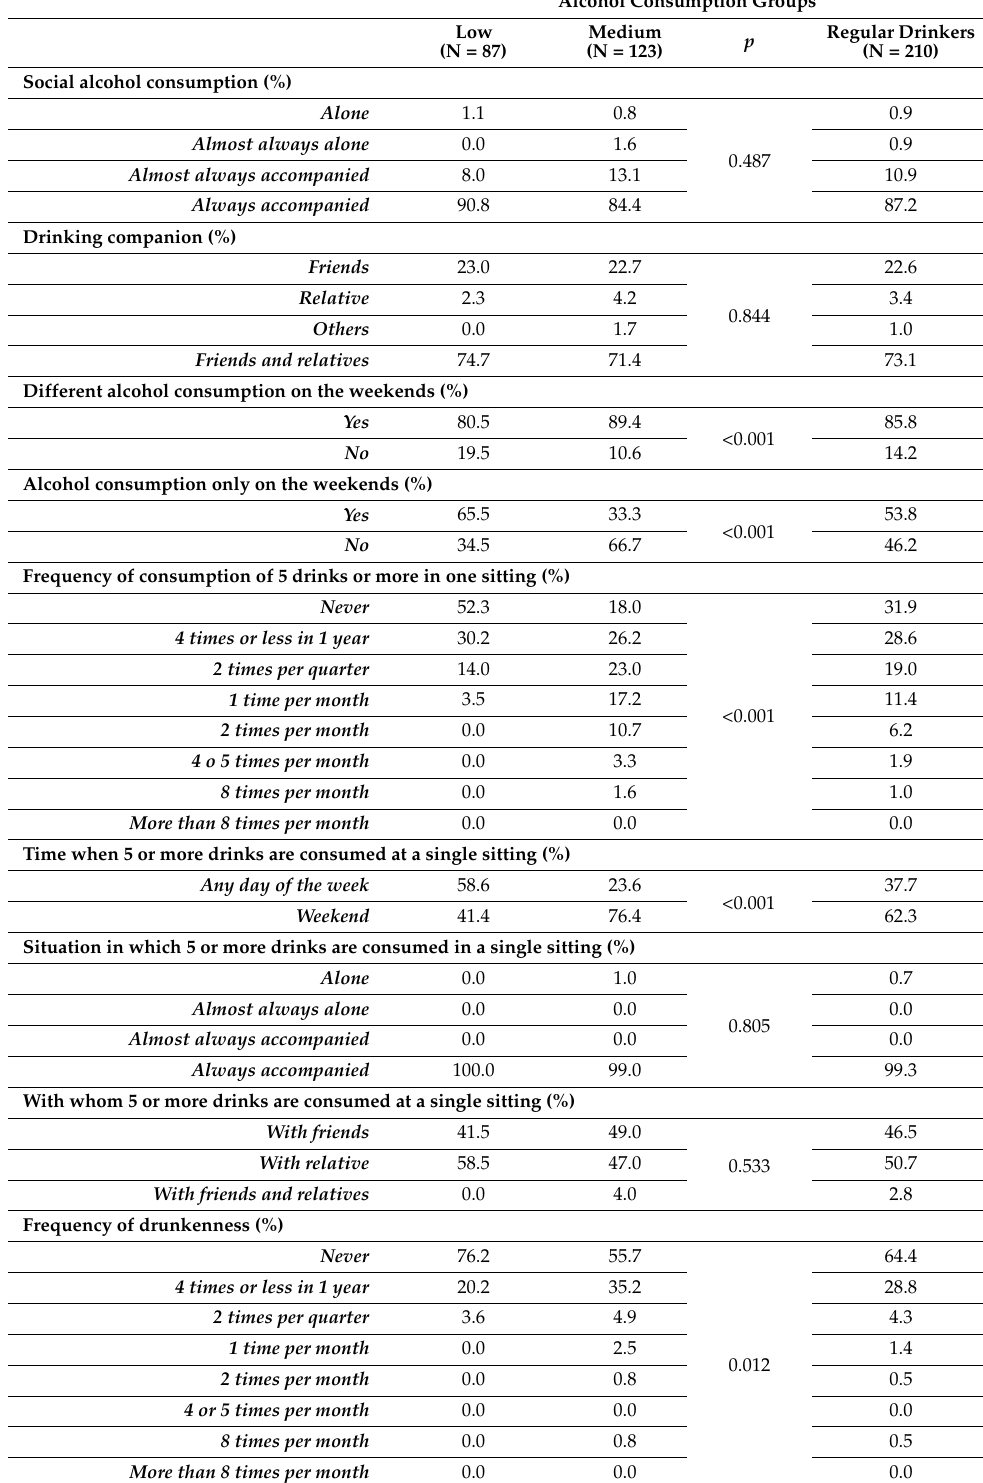
Table 3. Social pattern of alcohol